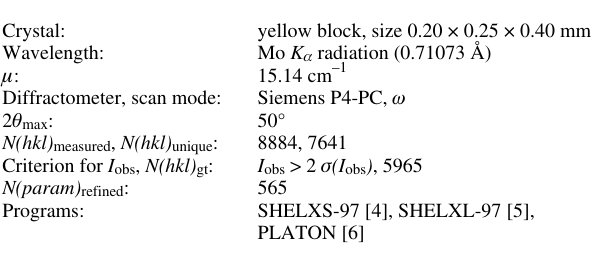
Table 1. Data collection and handling.